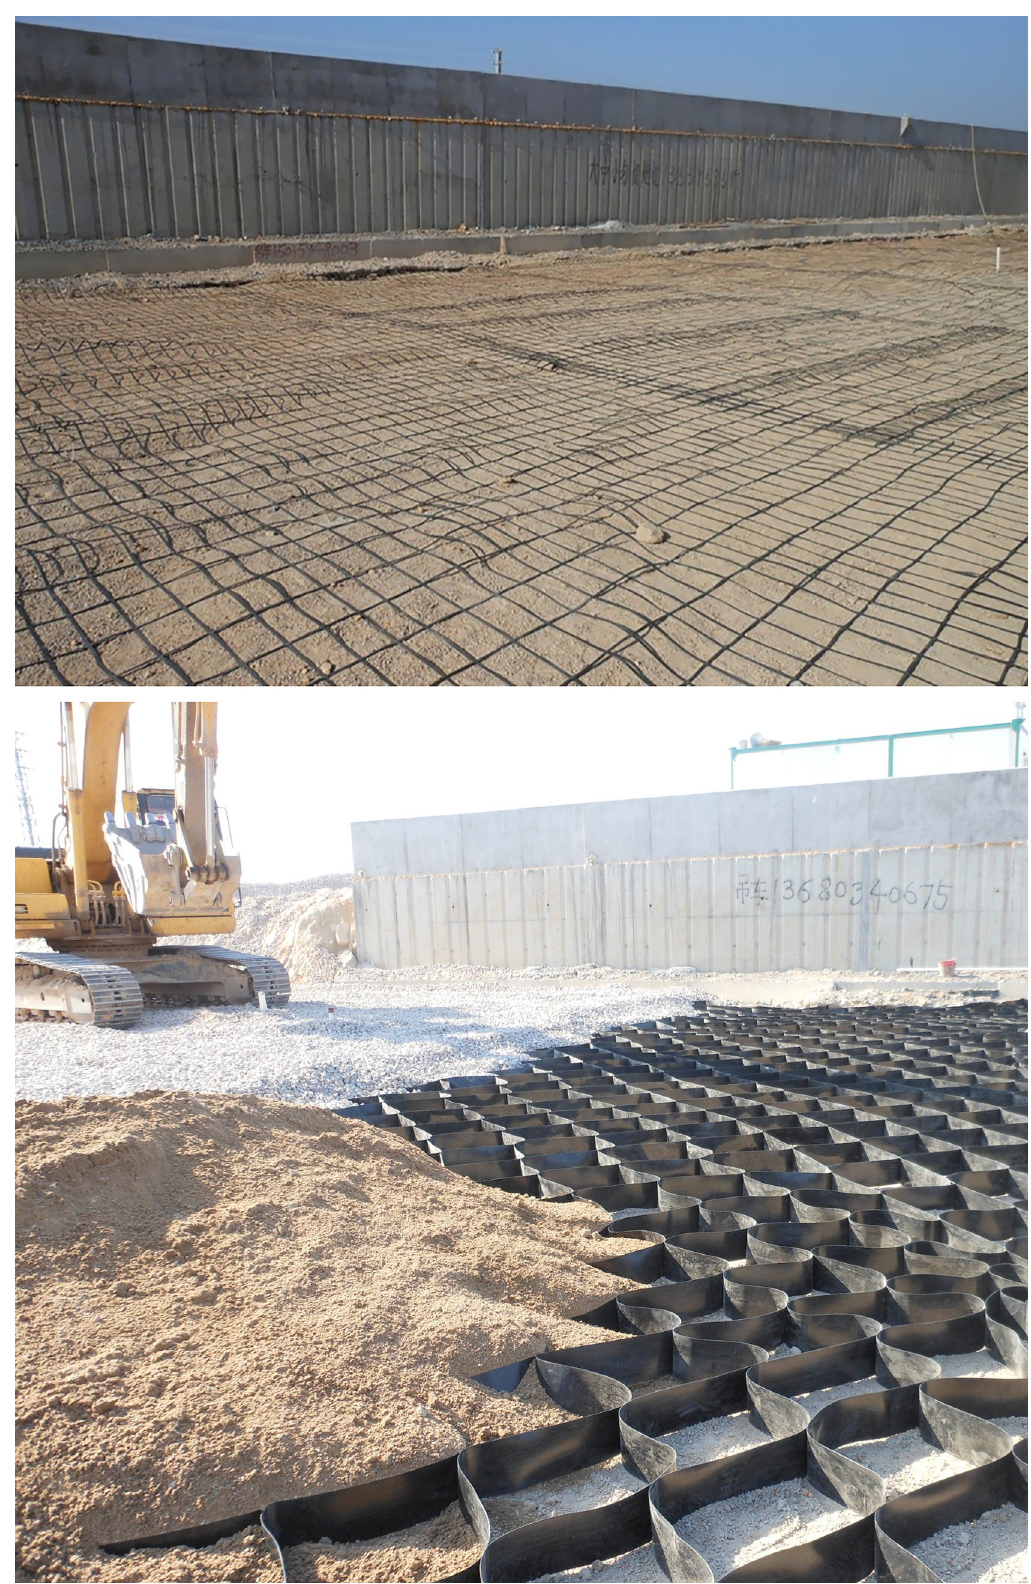
Fig 7. Site laying of the GR. (a)Geogrid laying. (b) Geocell laying.